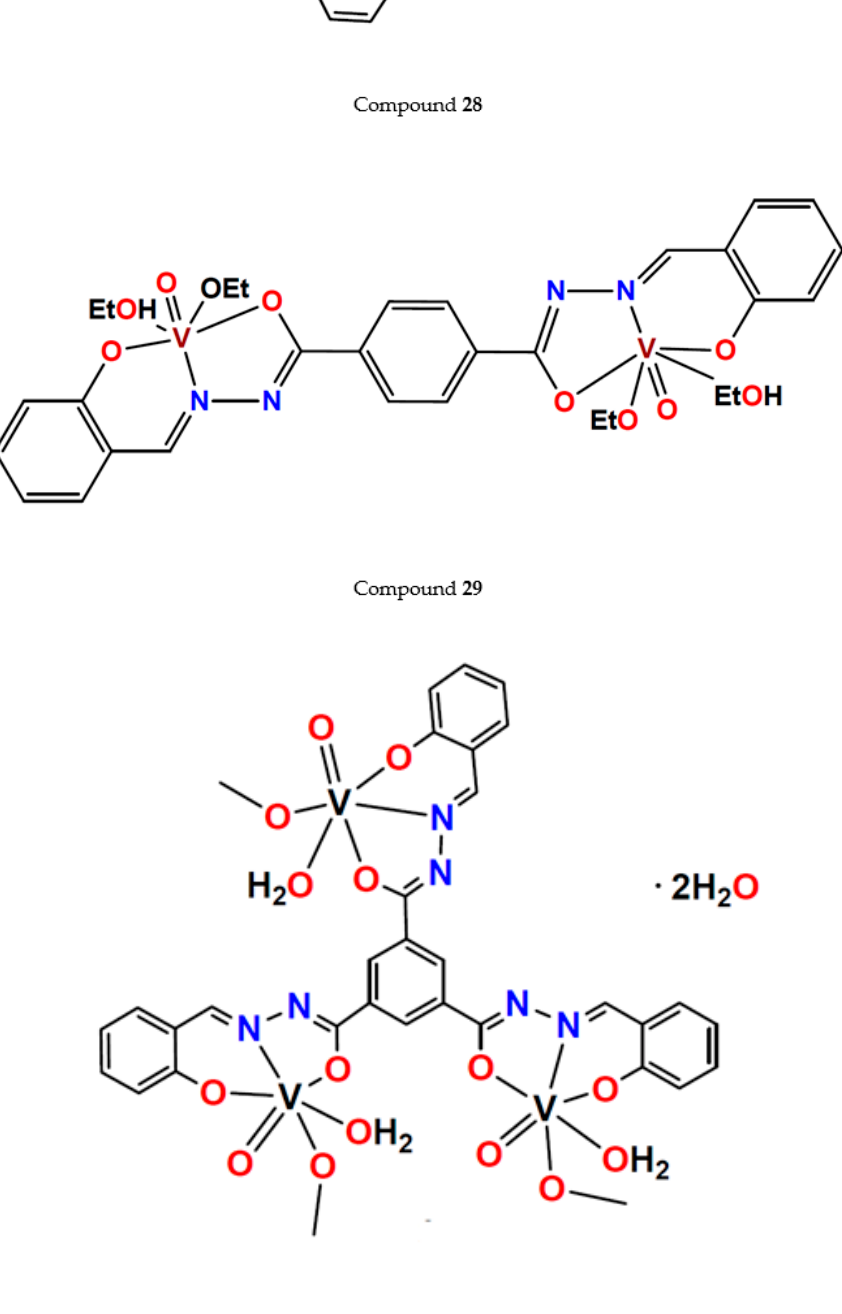
Figure 24. Vanadium Compounds tested as catalysts in oxidation with peroxides. Adapted from [159], Copyright (2019) with permission of Royal Society of